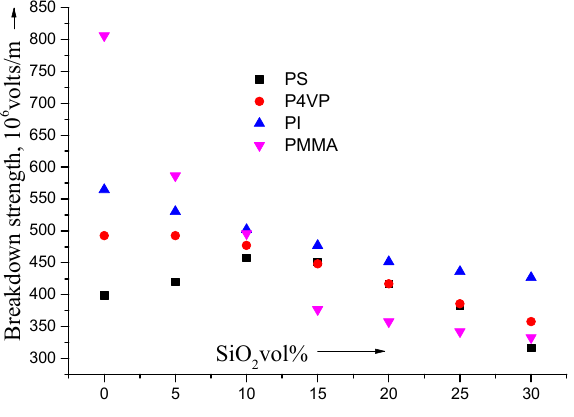
Figure 4. The breakdown strength (EBD) as a function of silica content for PS, P4VP, PI and PMMA. Less important ratios are for P4VP are where the EBD is reduced from 4.8 × 10 8 volts/m down to 4.4 × 10 8 volts/m (10%) when adding 15% v/v. However, for PS, the EBD is increased from